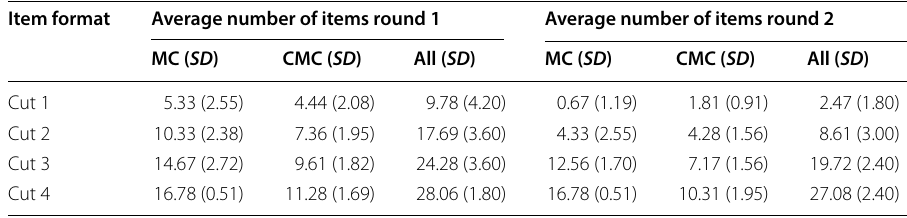
Number of items to be solved for MC and CMC items refers to number of items within the same item format MC multiple choice, CMC complex multiple choice, SD standard